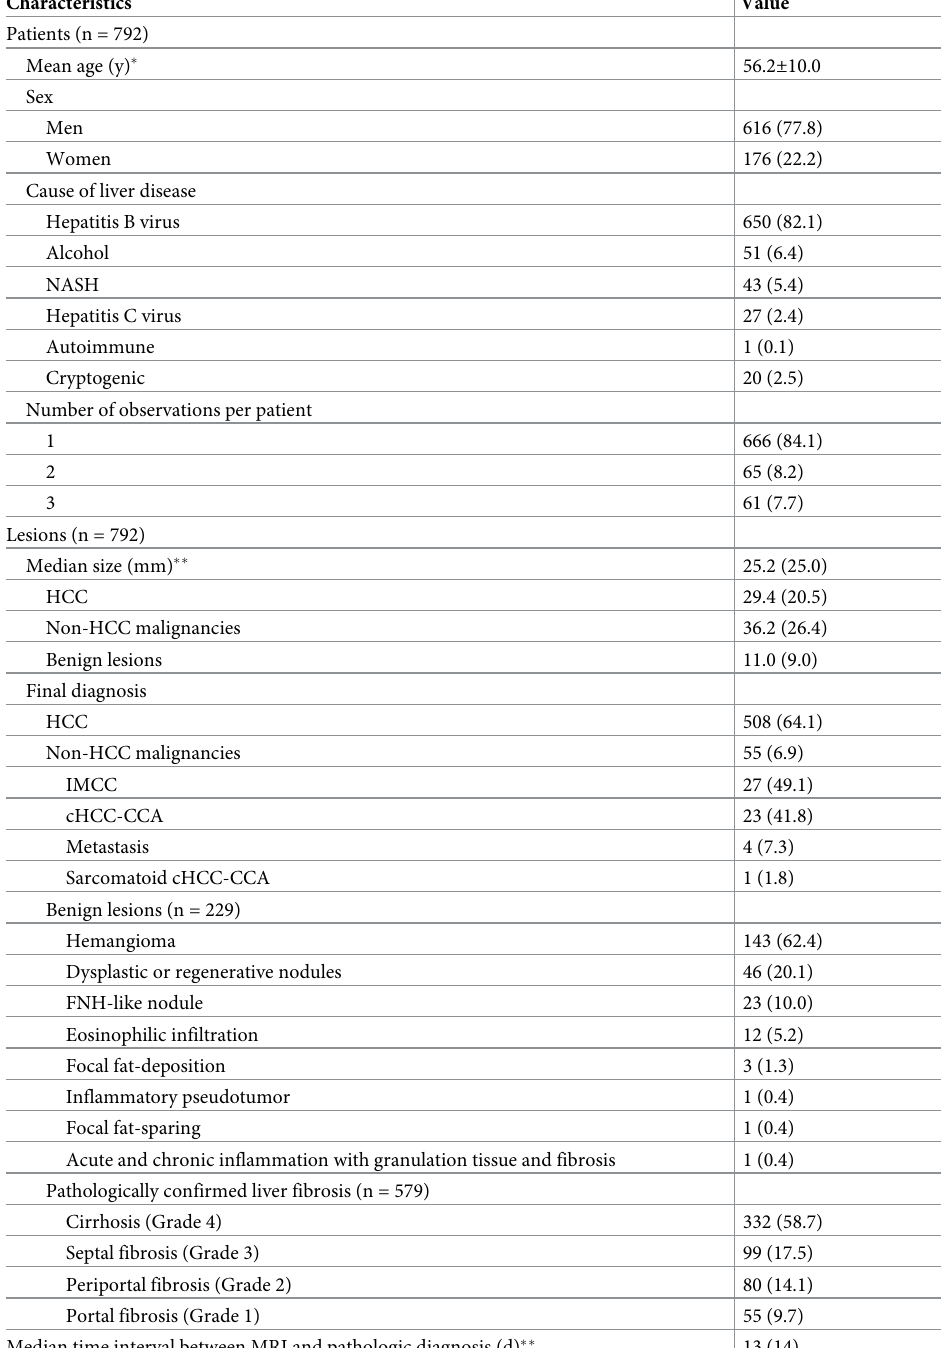
Table 1. Clinical-pathologic characteristics of patients and hepatic